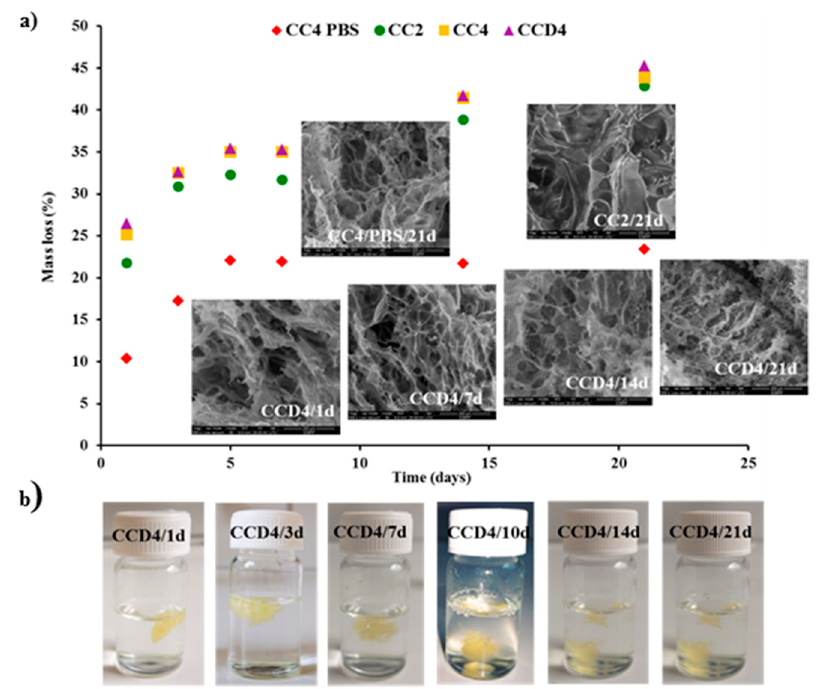
Figure 5. ( a ) Graphical representation of mass loss vs. time and several representative SEM images, and ( b ) images of the CCD4 drug delivery system during the enzymatic degradation experiment.